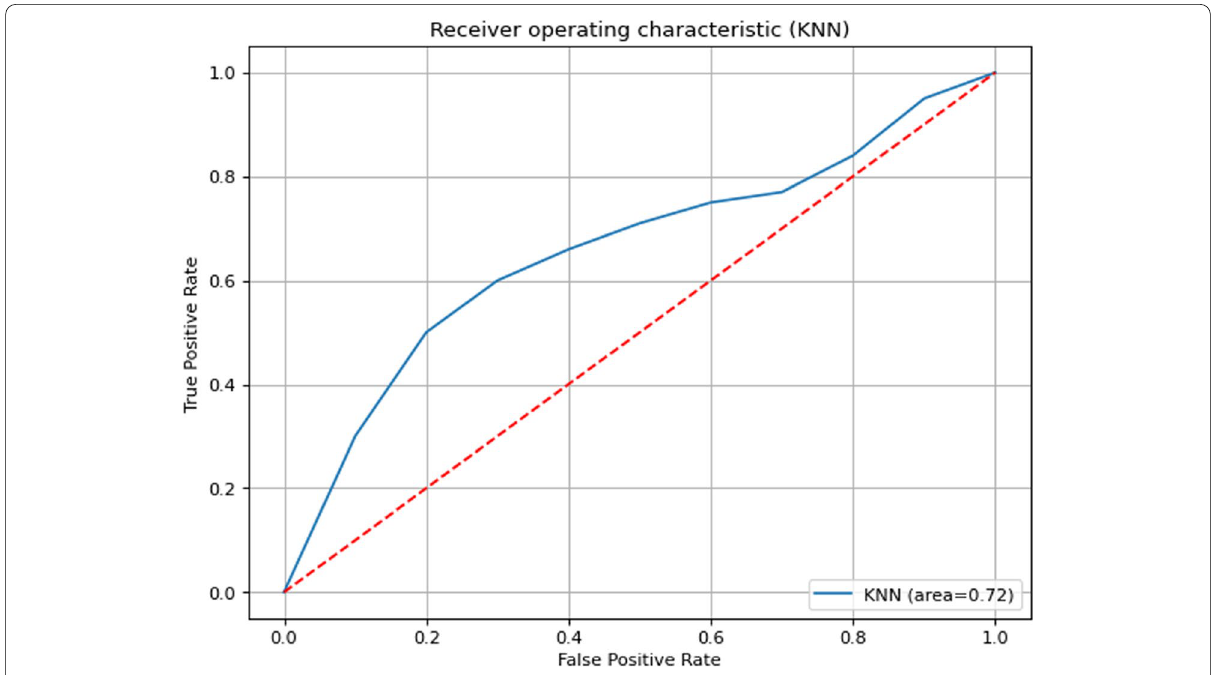
Fig. 24 ROC curve for our proposed model with SVM